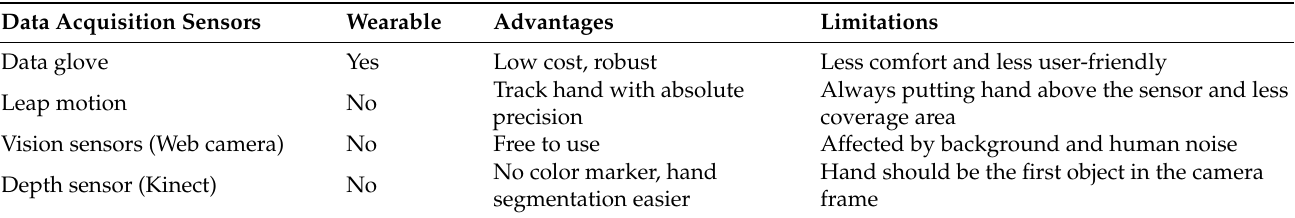
Table 1. Analysis of different sensors used for the recognition of hand